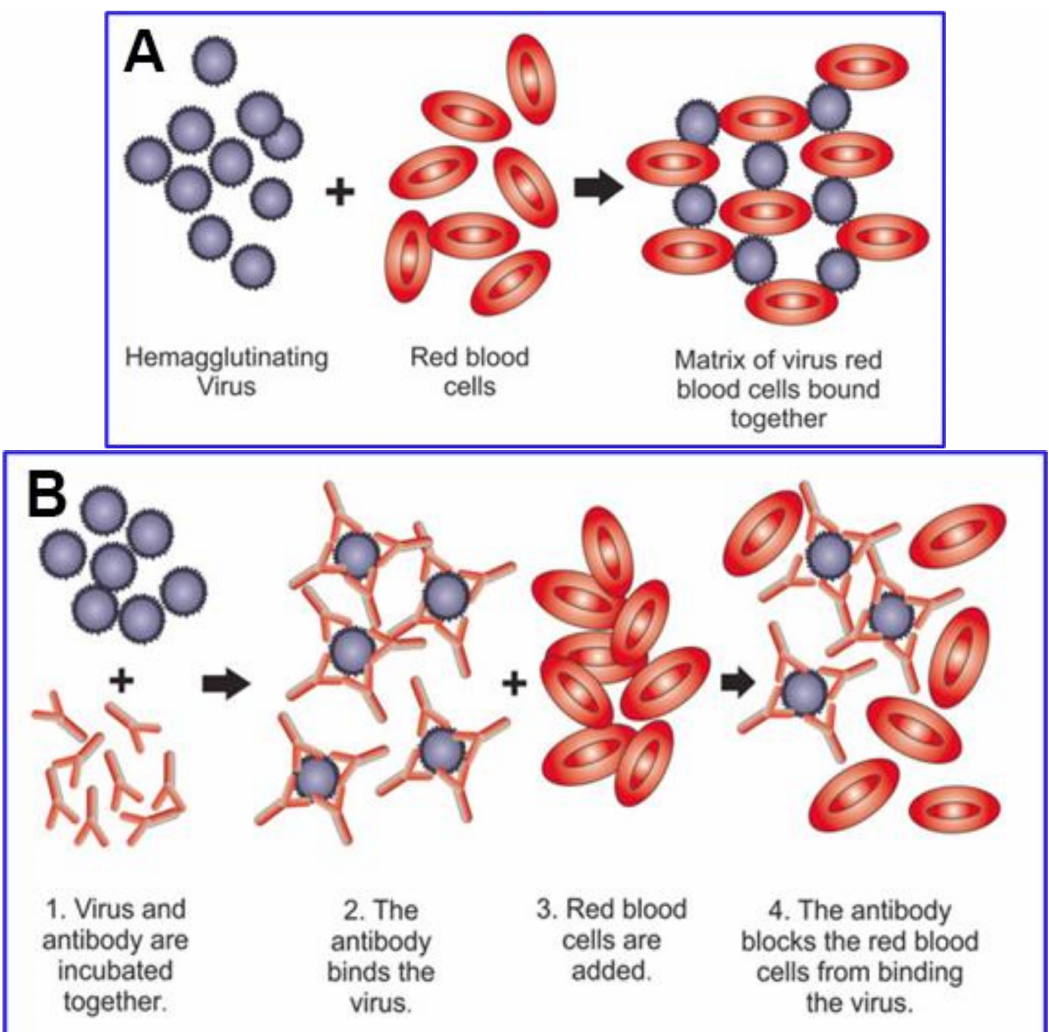
Figure 1. Schematic of hemagglutination ( A ) and hemagglutination inhibition ( B ), both of which occur either in vitro in their respective assays or in vivo. Reproduced with permission from Springer Nature (( A ) Killian, 2014 [57]; ( B ) Pedersen, 2014 [60]). ( B ) depicts blockage of hemagglutination by an antibody to the